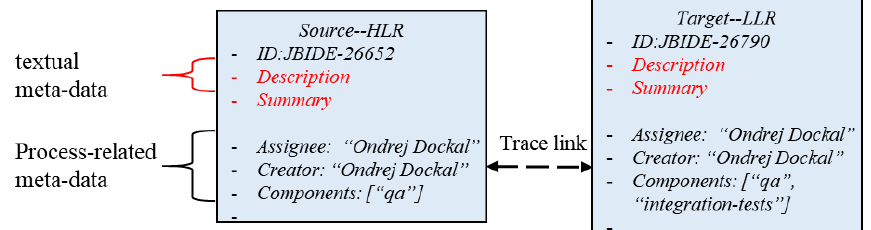
Figure 1. Example: indication effect of requirement process data for the creation of a trace link.